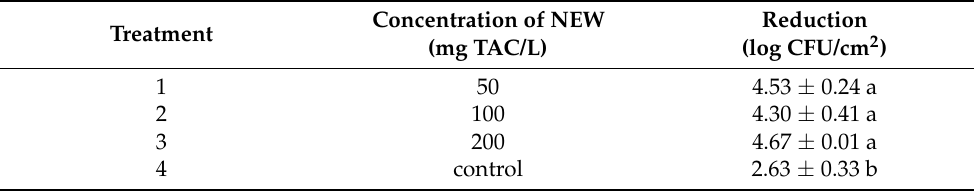
Table 8. Unifactorial design in the disinfection process with NEW at 20 ◦ C for 5 min. Treatment